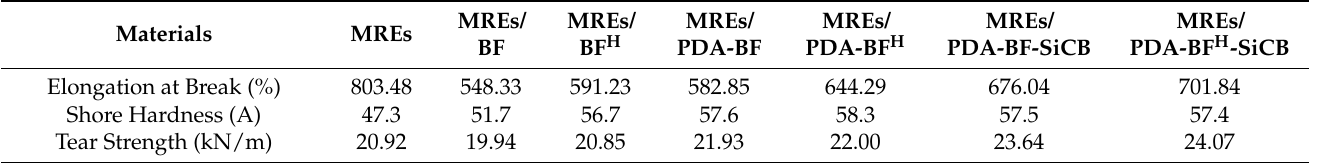
Table 4. Elongation at break values, Shore hardness values and Tear strength values of each group of